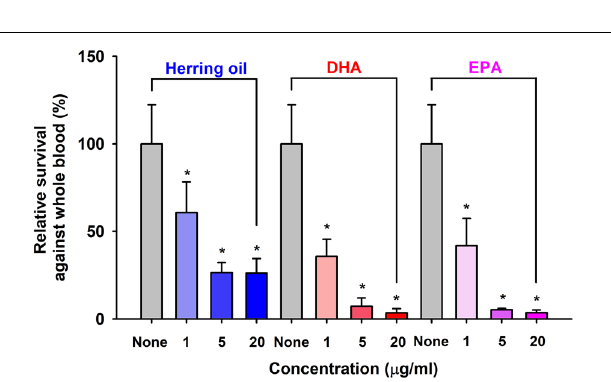
FIGURE 4 | Killing of S. aureus by whole blood cells in the presence of herring oil, DHA, or EPA. S. aureus cells were cultured in the presence of herring oil, DHA, or EPA at 1, 5, and 20 µ g/ml for 20 h, then mixed with freshly drawn human whole blood and cultured for 3 h. Percent survival of S. aureu s treated with or without the test compounds is represented. ∗ p < 0.05 vs. non-treated